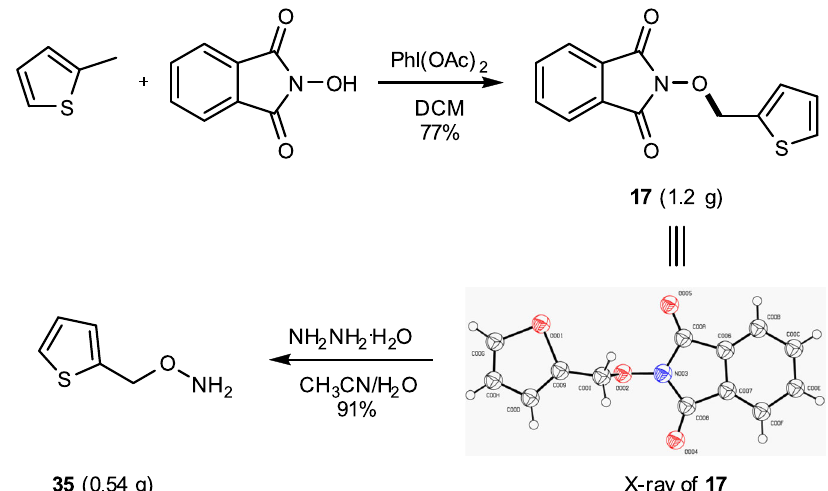
Fig. 4 A gram-scale experiment. Gram-scale with 2-methylthiophene and hydrazinolysis.